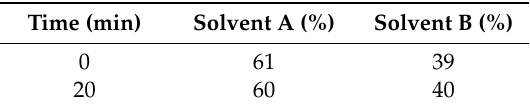
Table 1. Gradient elution system for HPLC